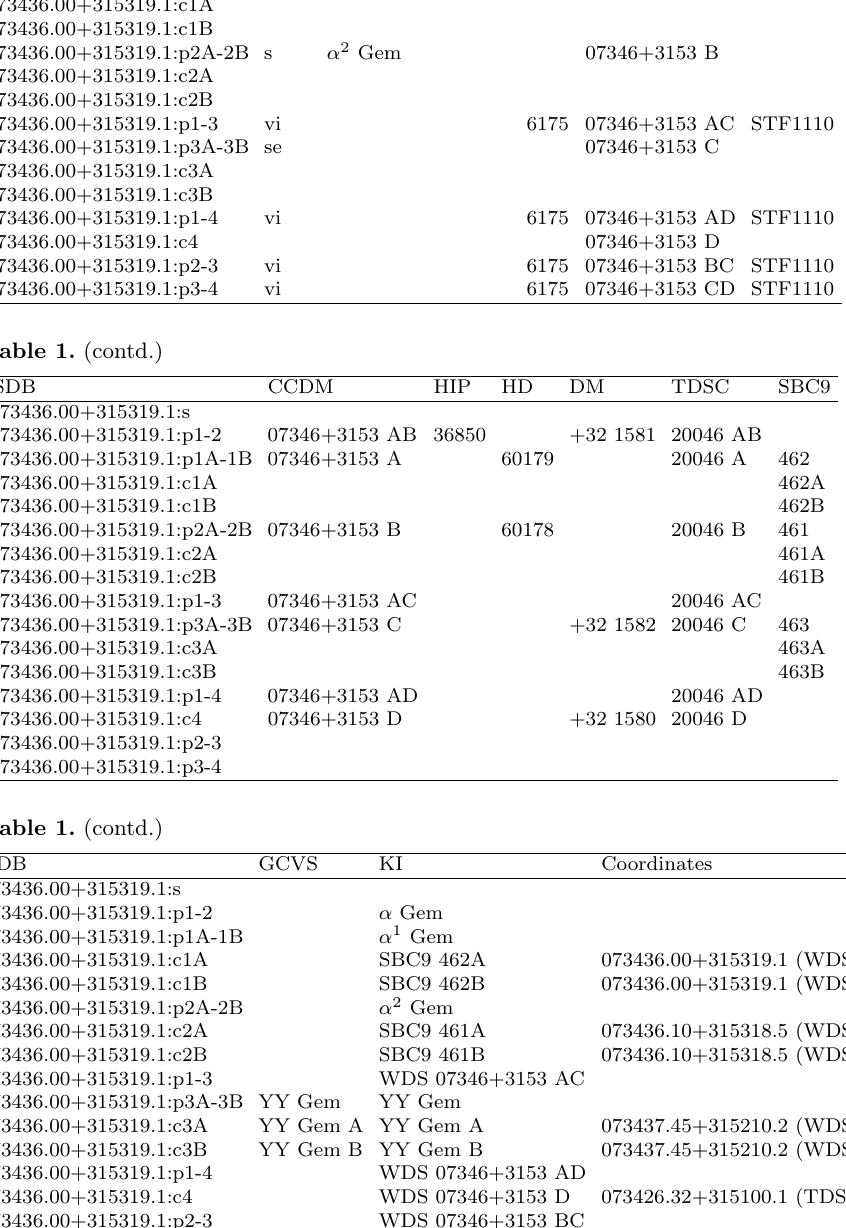
Table 1. ILB. An example: Castor. Some columns are empty and not shown here.